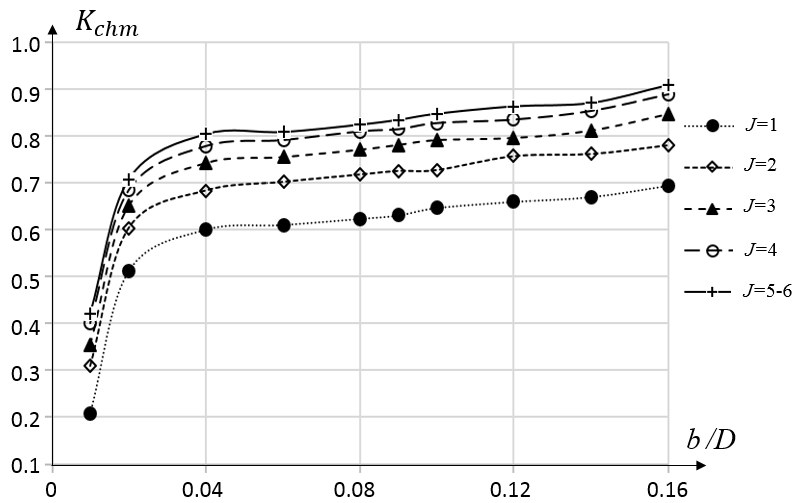
Figure 6. Uniformity coefficient K chm of foam concrete mixture vs. normalized width b/D and number J of reflective partitions (experimental data).